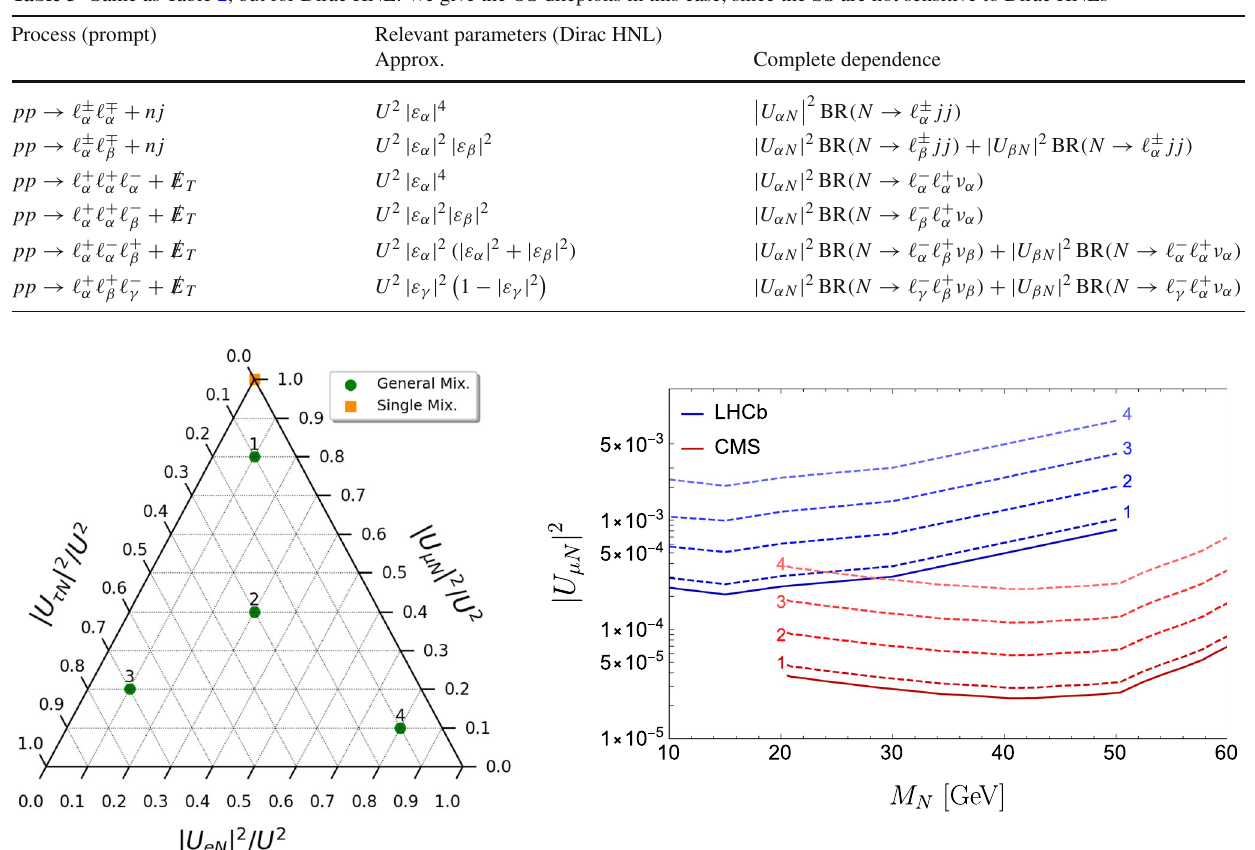
Fig. 3 Rescaling of the bounds on | U μ N | 2 from CMS [69] (solid red line) and LHCb [83] (solid blue line), fixing the active − sterile mixings to the values corresponding to the green points 1 − 4 in the ternary plot on the left. The orange squared point represents the single mixing